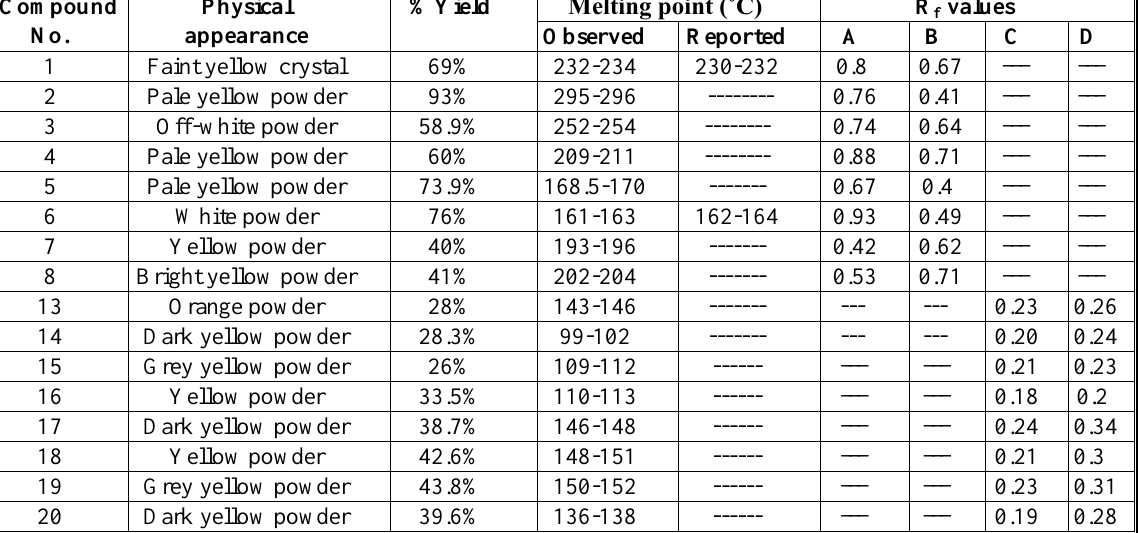
Table (1): The physical appearances, percentage of yield, melting points, R intermediate and final compounds